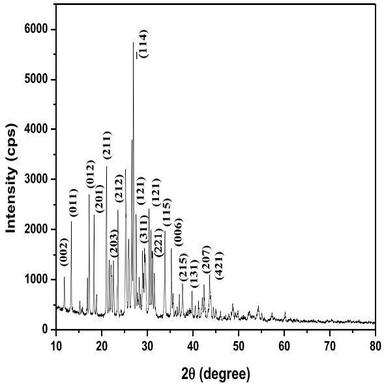
G4C3NBM crystal's FTIR spectrum.